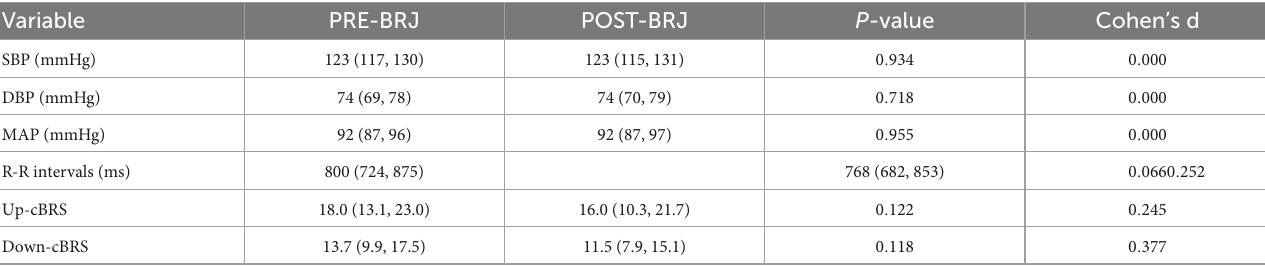
TABLE 3 Blood pressure, cerebral artery blood velocity, and indices of static cerebral autoregulation during static lower-body negative pressure before and 3 h after beetroot juice (BRJ) consumption. Variable PRE-BRJ POST-BRJ P -value